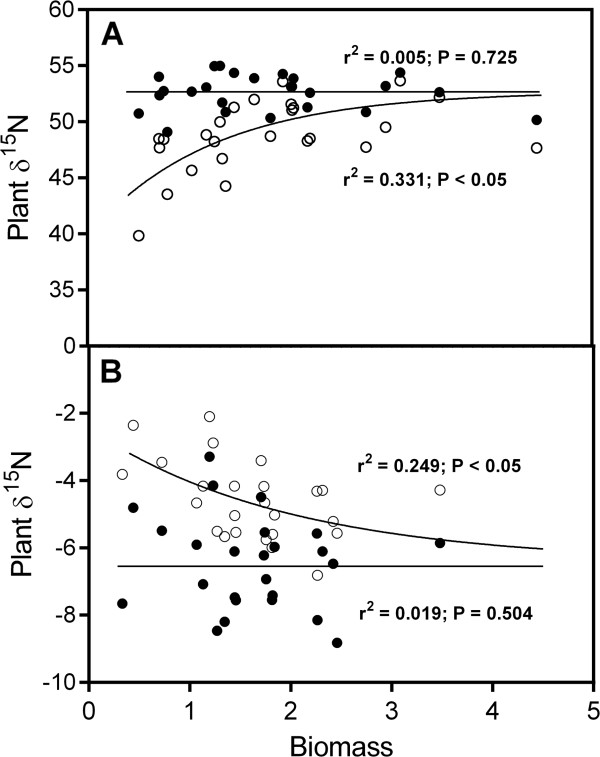
Unadjusted (open symbols) and adjusted (closed symbols) δ15N for new growth of the whole plant plotted against biomass for Populus balsamifera L. grown with either nitrate (A) or ammonium (B). Each data point represents a genotypic mean (N = 3). Correlation coefficients and P-values are placed near each line.